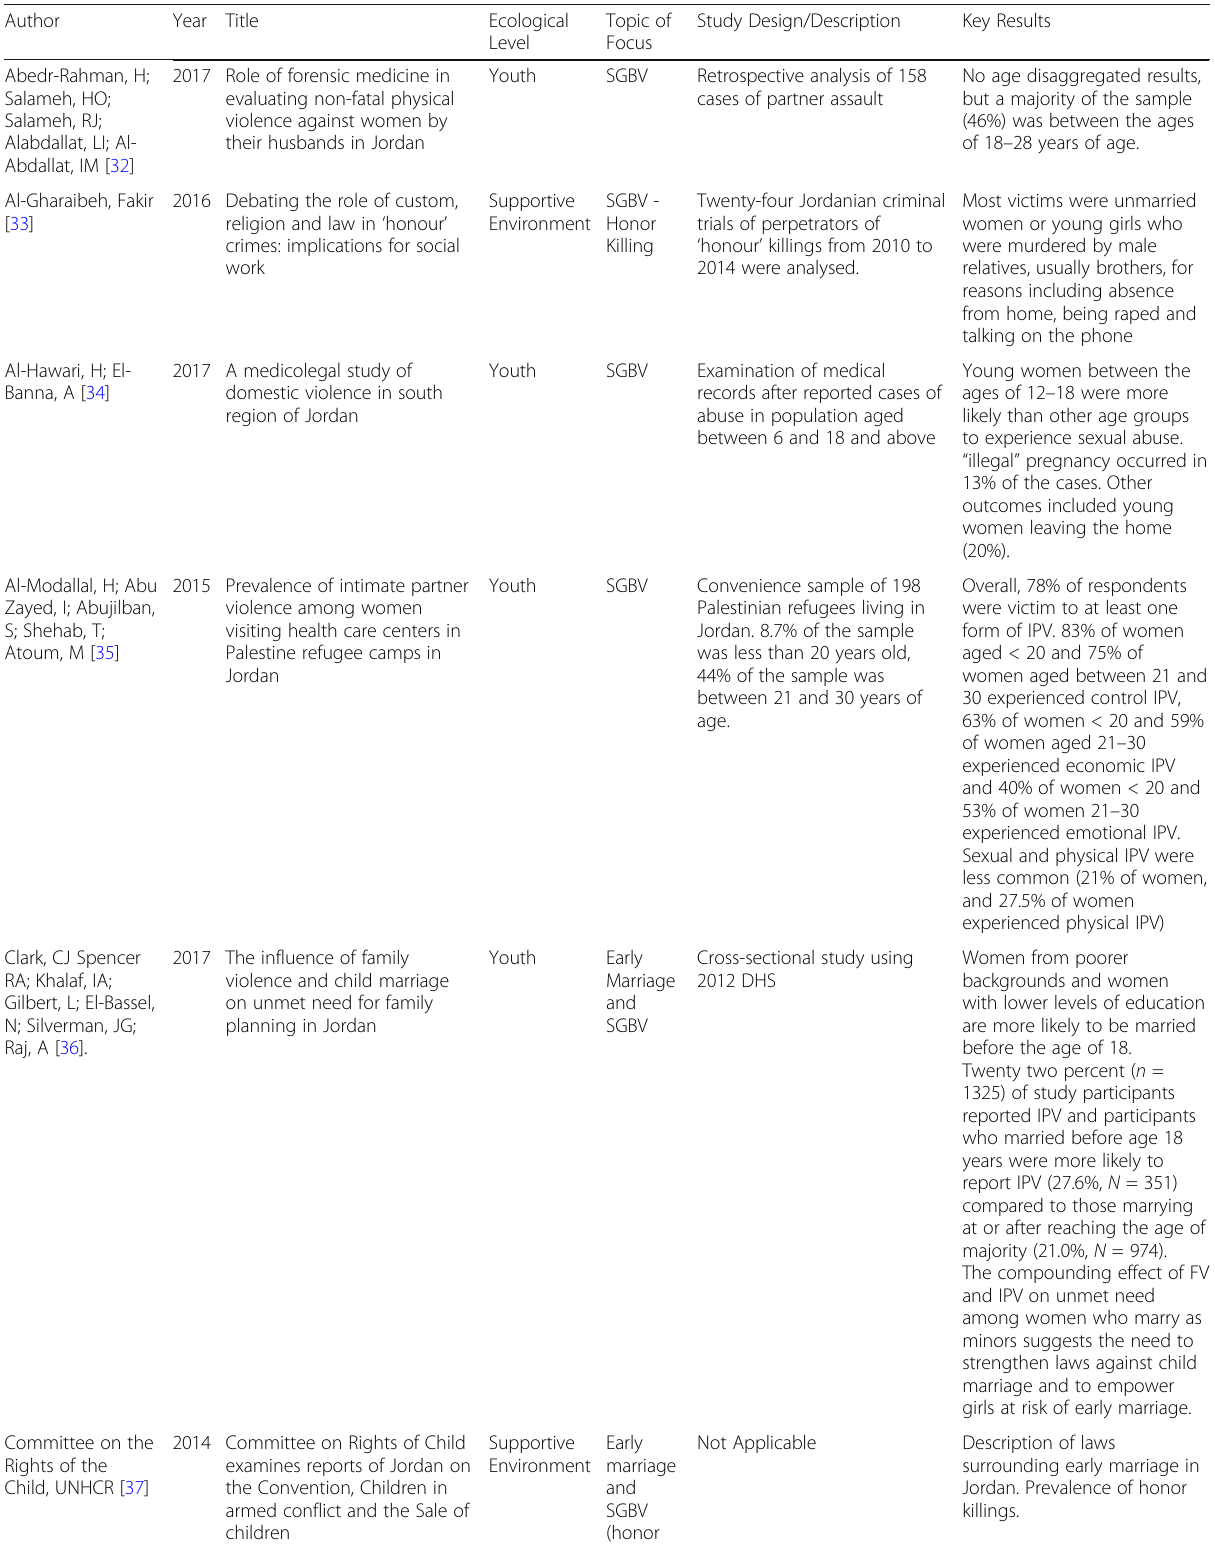
Table 1 Summary of the 27 documents included in the analysis according to ecological level and topic of focus pertinent to sexual- and gender-based violence and early marriage among youth in